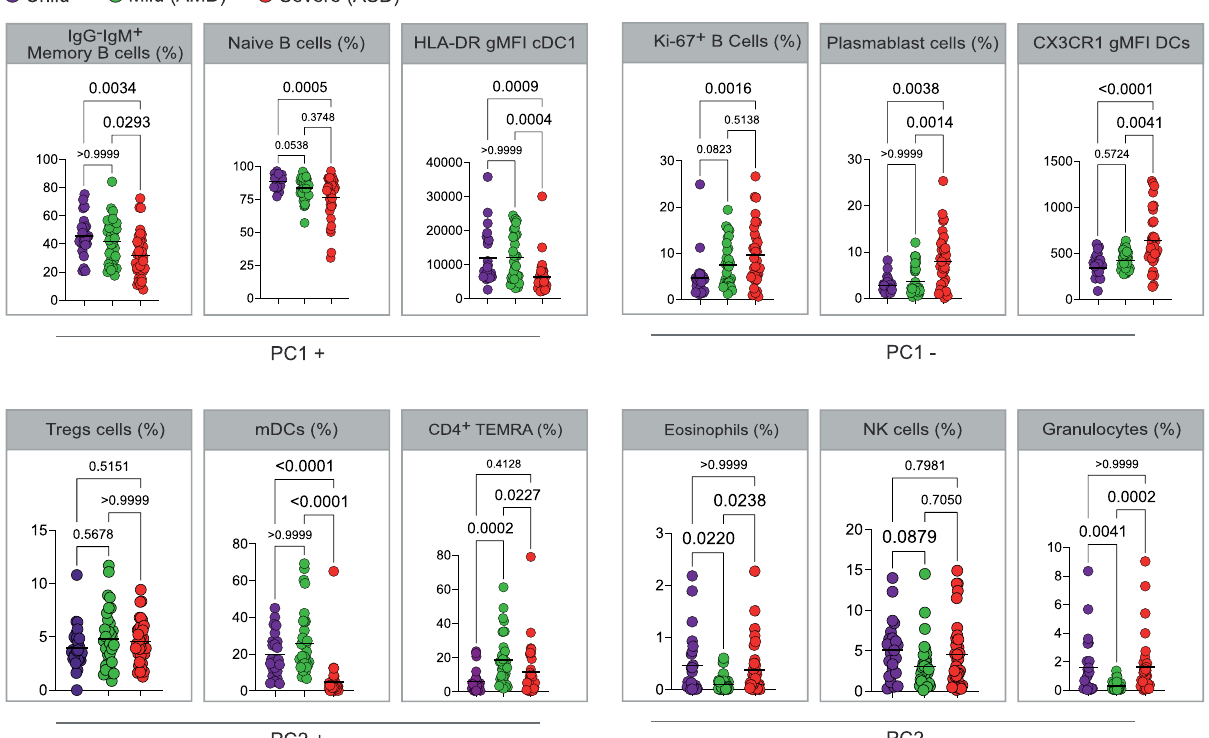
Fig. 2 Analysis of variance of the main variables contributing to principal components. A , B Kruskal – Wallis tests comparing values of each of the three immune variables that presented the highest in fl uences — either positive ( A ) or negative ( B ) for PC1, PC2 and PC3. Each dot represents a patient, color coded: children — purple, adult with mild disease — green, and adult with severe disease — red. P values are indicated over brackets, the horizontal bar representing the mean. Source data are provided as a Source Data fi